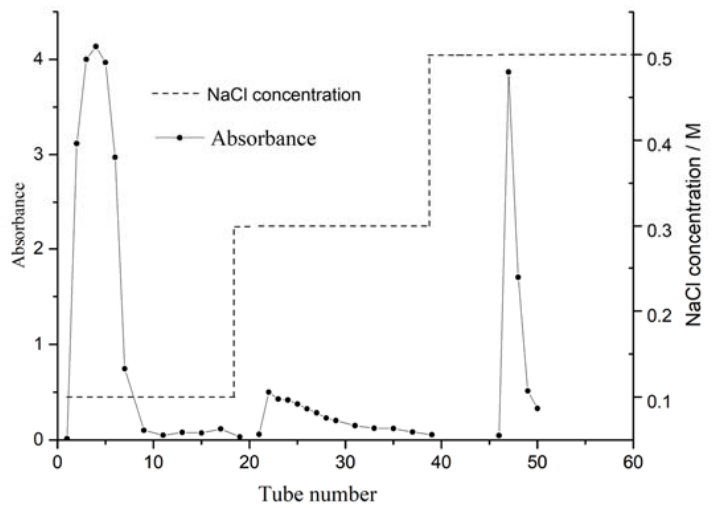
Figure 1. Chromatographic elution curves of CALP on DEAE ‐ 52 cellulose column.